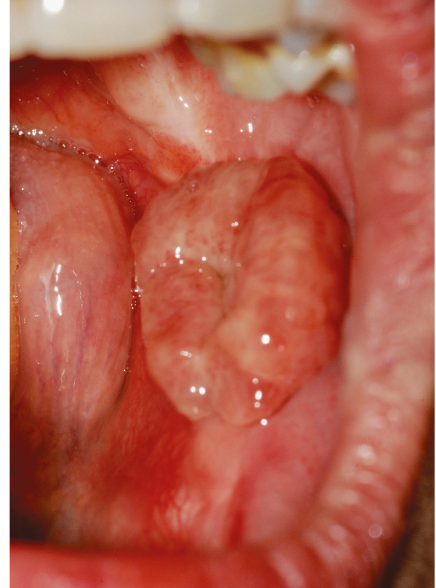
Figure 3: Clinical preoperative.